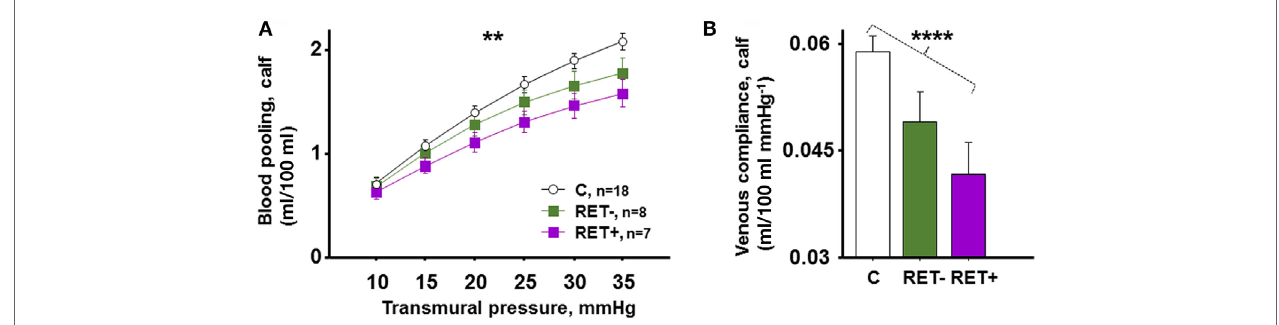
FigUre 5 | (a) LBNP-induced blood pooling in C ( n = 18), RET − (DW with no signs of retinopathy, n = 8) and RET + (DW with signs of retinopathy, n = 7). C pooled the greatest amount of blood, followed by RET − and RET + , with progressively reduced blood pooling seen in this order ( P = 0.003). (B) Corresponding mean venous compliance during transmural pressure of 10–35 mmHg in identical groups, with gradually reduced venous compliance in C, RET − , and RET + ( P <